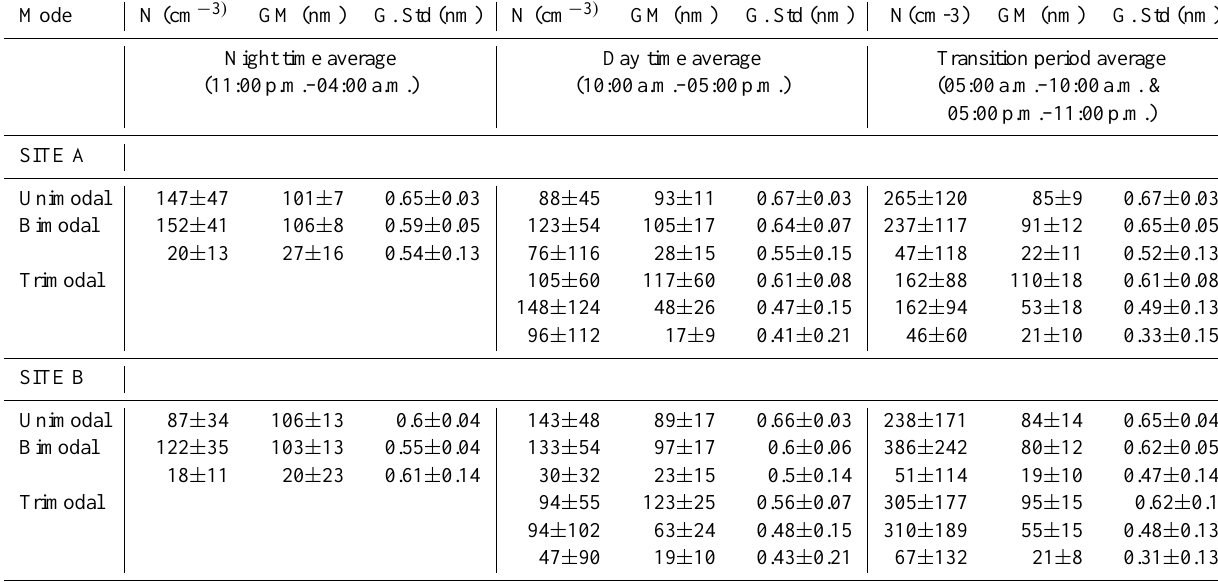
Table 1. Parameters of the Multi-lognormal Fits for the measured aerosol size distribution. Mode